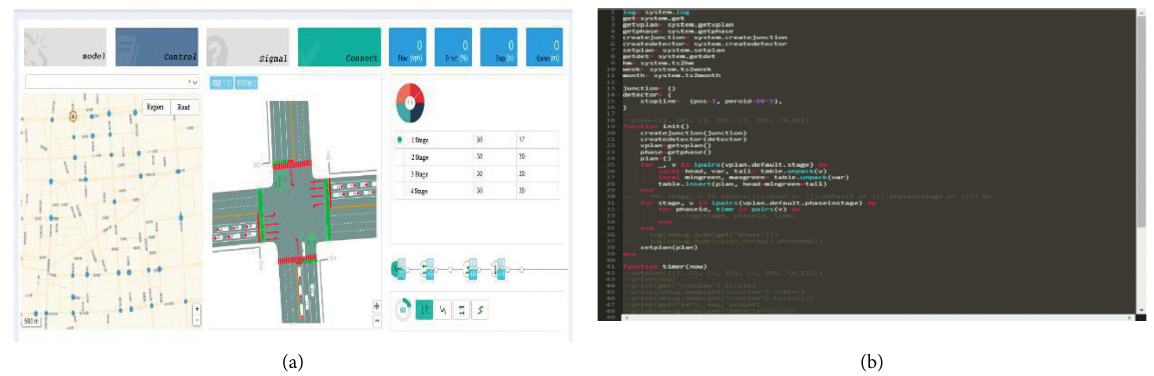
Figure 14: Intersection test. (a) Model of road network. (b) Algorithm implementation and